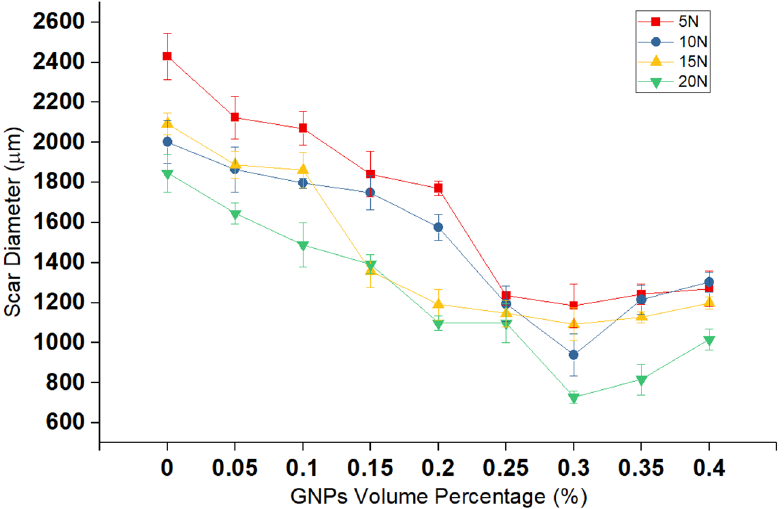
Figure 9. Wear-scar diameter of pins at 15 N for samples tested with ( a ) neat oil, ( b ) 0.10 vol.% nanolubricant, and ( c ) 0.30 vol.% nanolubricant.